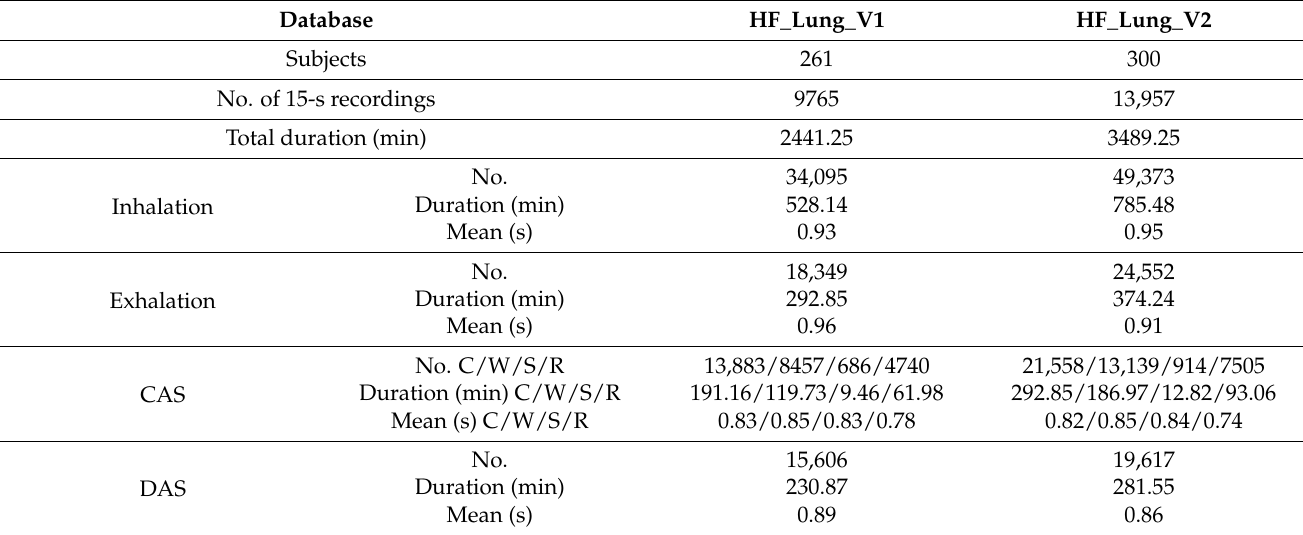
Table 2. Statistical data of lung sound files in HF_Lung_V1 and HF_Lung_V2 databases.